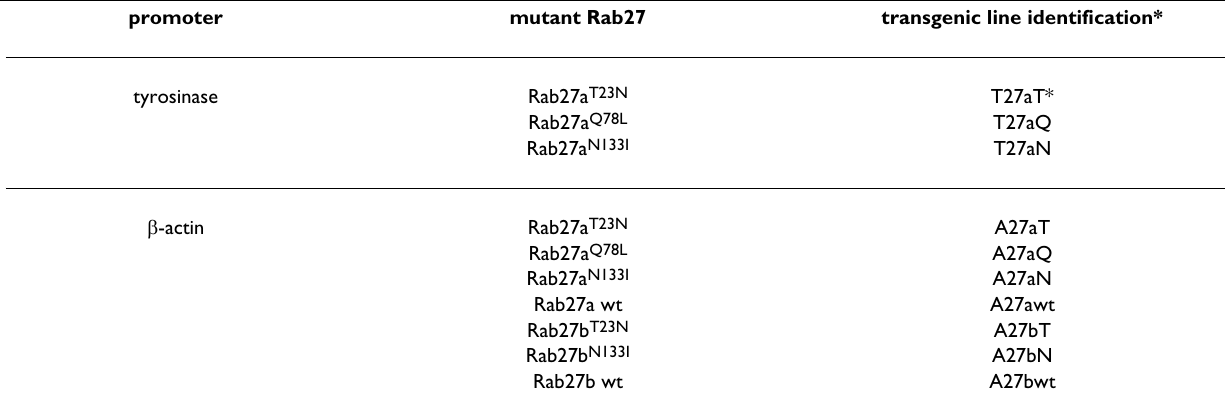
Table 2: Nomenclature for transgenic